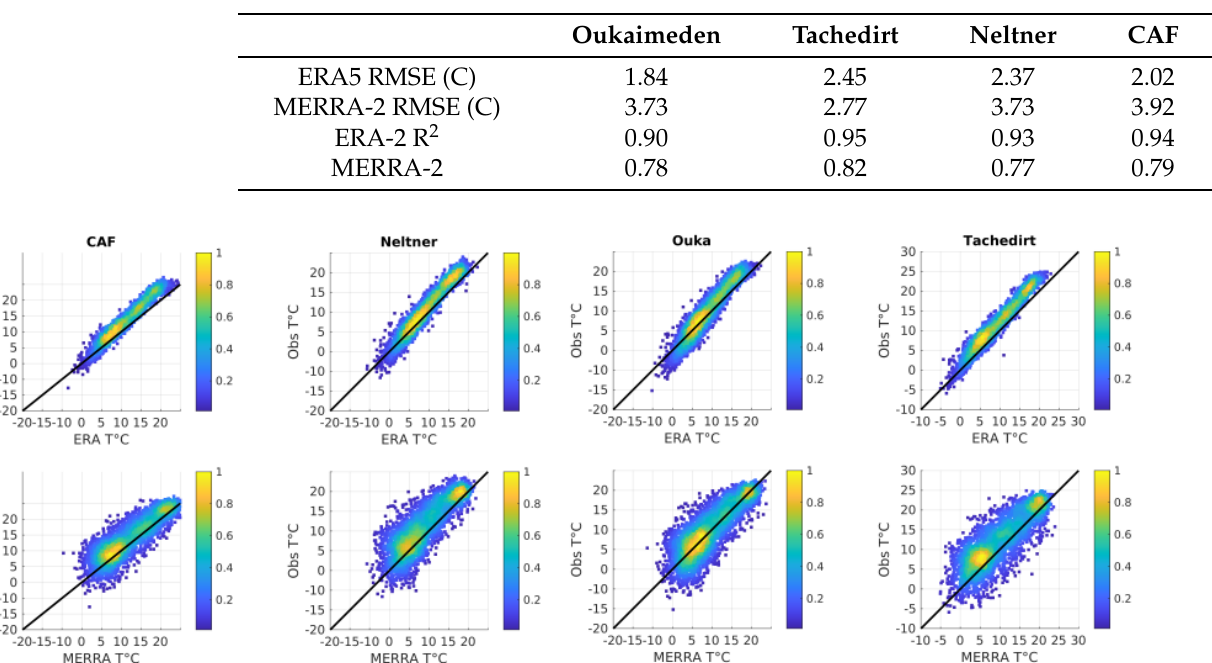
Table 4. Indicators to evaluate MERRA-2 and ERA5 reanalysis with observed temperature (RMSE and R 2 ).